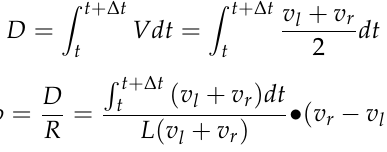
expressed by Equation (10).